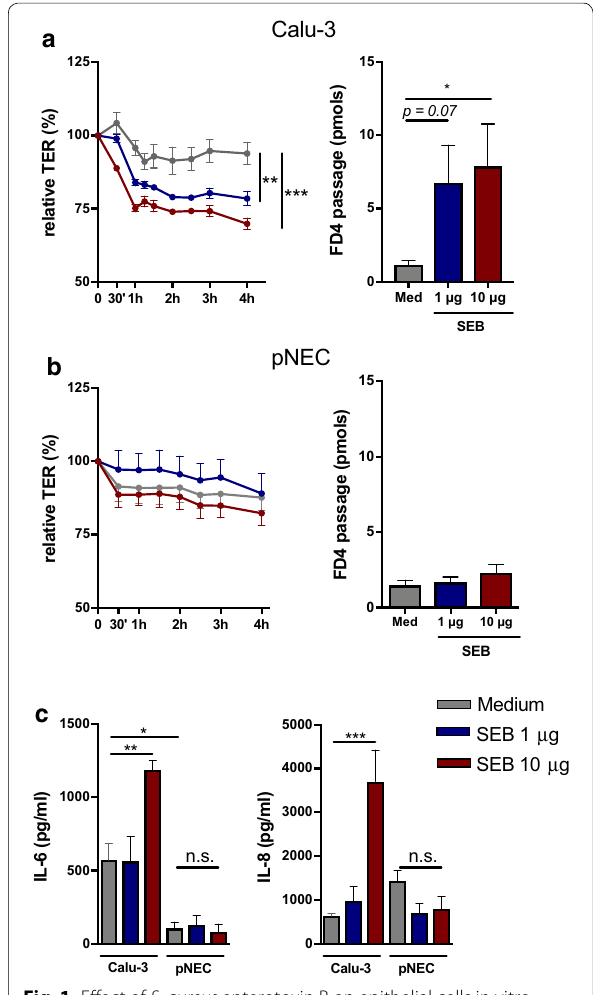
Fig. 1 Effect of S. aureus enterotoxin B on epithelial cells in vitro. Primary nasal epithelial cells (n 5) and Calu-3 epithelial cells = (n 3) at air–liquid interface were stimulated for 4 h with different = concentrations of SEB. a Evaluation of trans-epithelial electrical resistance (TER) for 4 h of Calu-3 epithelial cell cultures. FD4 permeability of Calu-3 epithelial cells at time point 4 h. b Evaluation of TER for 4 h of primary nasal epithelial cells from heathy controls. FD4 permeability of primary nasal epithelial cells at time point 4 h. c Concentration of IL-6 and IL-8 in the supernatant of SEB stimulated Calu-3 or primary nasal epithelial cell cultures. Data presented as mean SEM. One-way ANOVA with post hoc test. * p < 0.05; ** p < 0.01; ± *** p < 0.001; ns not